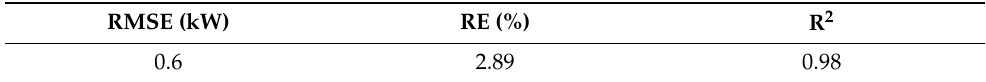
Figure 4. Fitting of the measured power to simulated power using the calibrated parameters. The statistic indicators of the goodness of fit of the simulated vs. measured power can be observed in Table 3. Table 3. Goodness of fit of the calibrated model for the absorbed electric power. RMSE (kW)